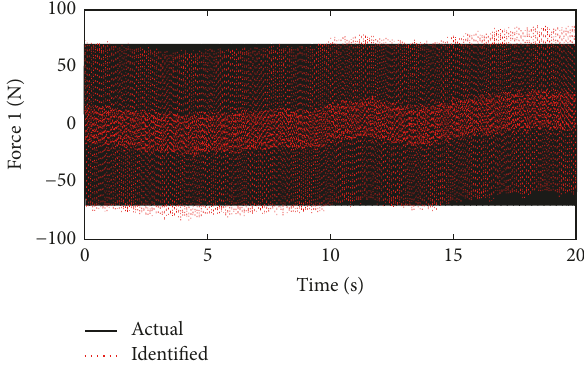
Figure 2: The actual and identified results of force 𝑢 1